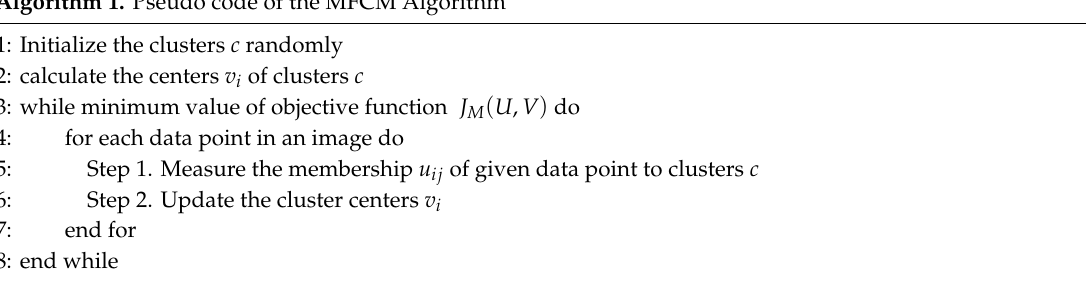
Algorithm 1. Pseudo code of the MFCM Algorithm